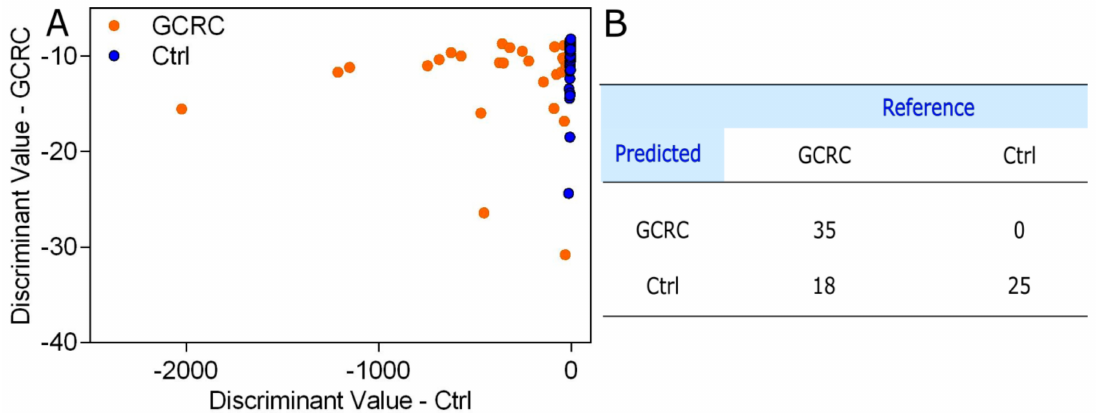
Figure 4. Principal component analysis-quadratic discriminant analysis (PCA-QDA) of the SERS spectra of serum. ( A ) The prediction plot of the PCA-QDA based on the SERS profiling of serum from 53 patients with gastric and colorectal cancer (GCRC) and 25 control subjects (Ctrl) using the first seven principal components as input. ( B ) The confusion matrix yielded by the PCA-QDA of the SERS spectra of